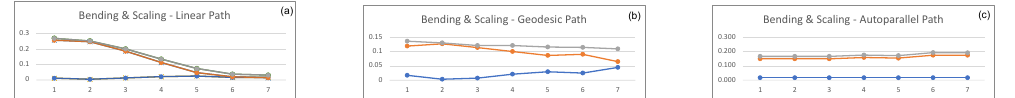
Figure 11. Trend of the energies for different interpolations: ( a ) Left: linear interpolation ( b ) Center: geodesics interpolation. ( c ) Right: autoparallel interpolation. Blue refers to d u , red to d b , grey to d tot